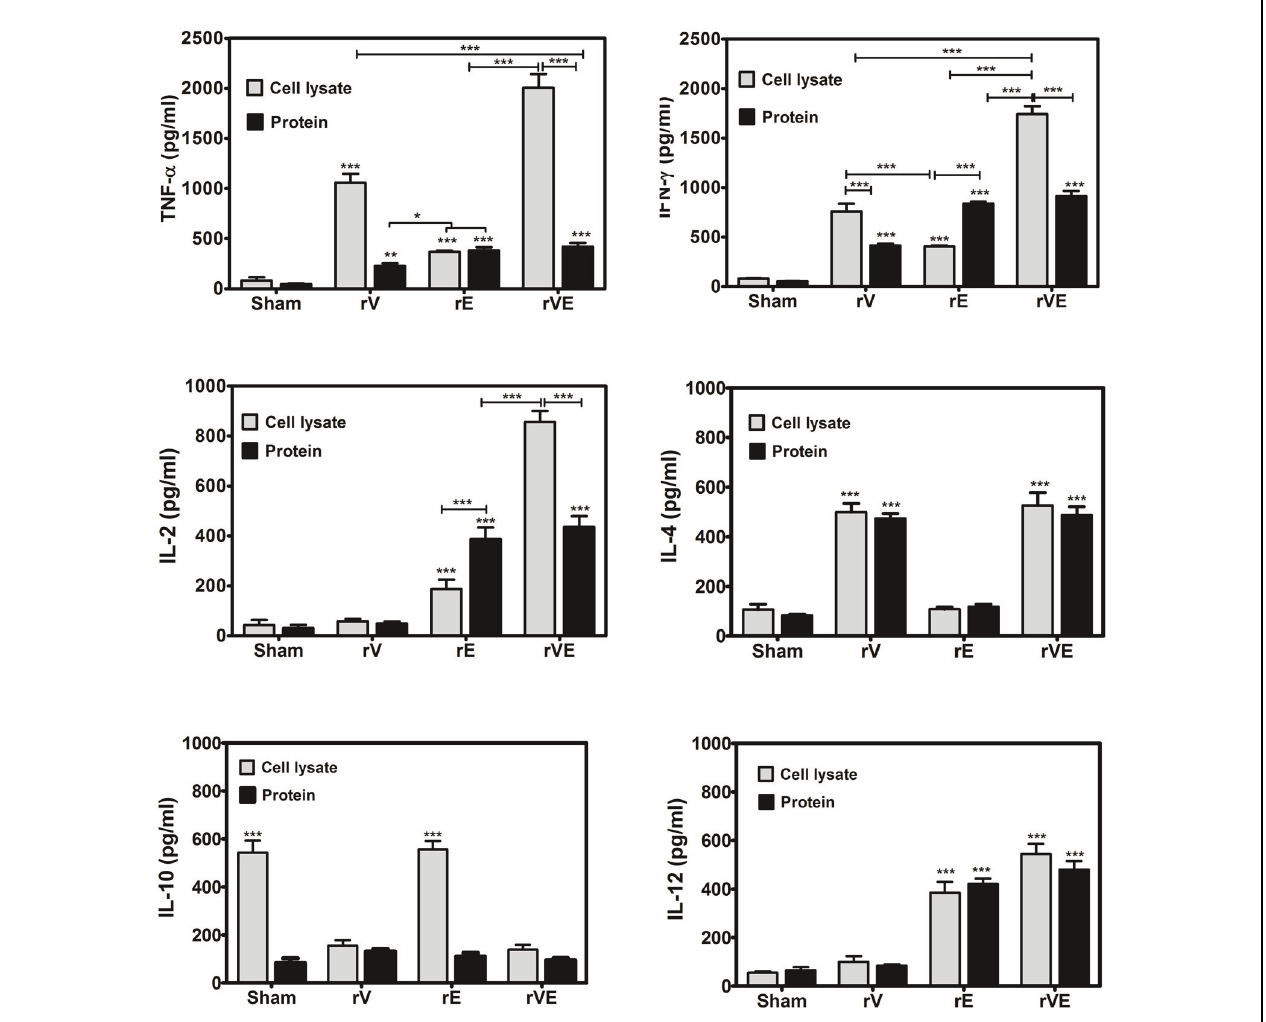
FIGURE 4 | Cytokine profile in mice immunized with recombinant proteins rV, rE, and rVE. Splenocytes isolated from immunized BALB/c mice at 43rd day after initial immunization were stimulated in vitro with 30 μ g/ml of respective recombinant purified proteins or whole cell lysate of 10 6 Y. enterocolitica . The sham immunized mice splenocytes stimulated with purified proteins (rV, rE, and rVE) or whole cell lysate were considered as negative controls. Levels of pro-inflammatory (IFN- γ , TNF- α , IL-2, IL-12) and anti-inflammatory (IL-4, IL-10) cytokines in the culture supernatants produced from splenocytes after 72 h of incubation were measured by Mabtech ELISA kit. Data represent the mean ± SD of the results determined. ∗ P < 0.05; ∗∗ P < 0.01; ∗∗∗ P <